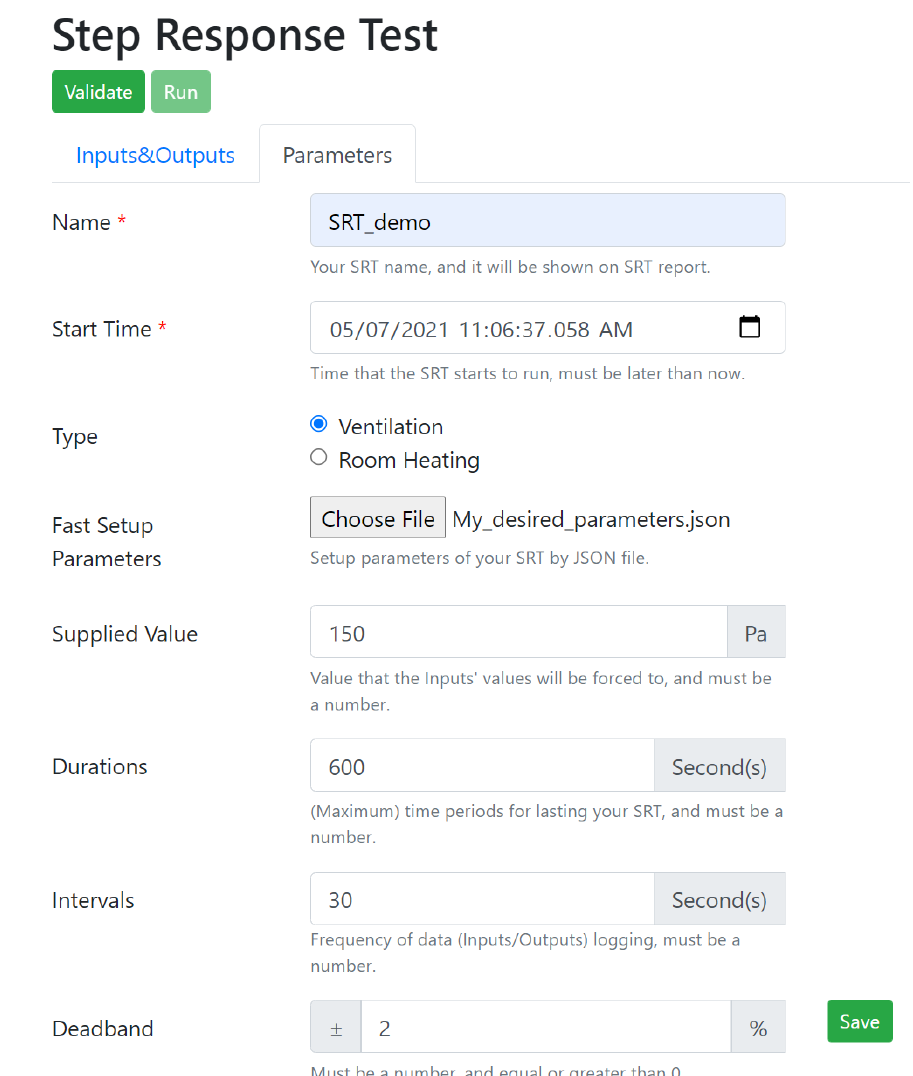
Figure 6. Interface for configuration of the